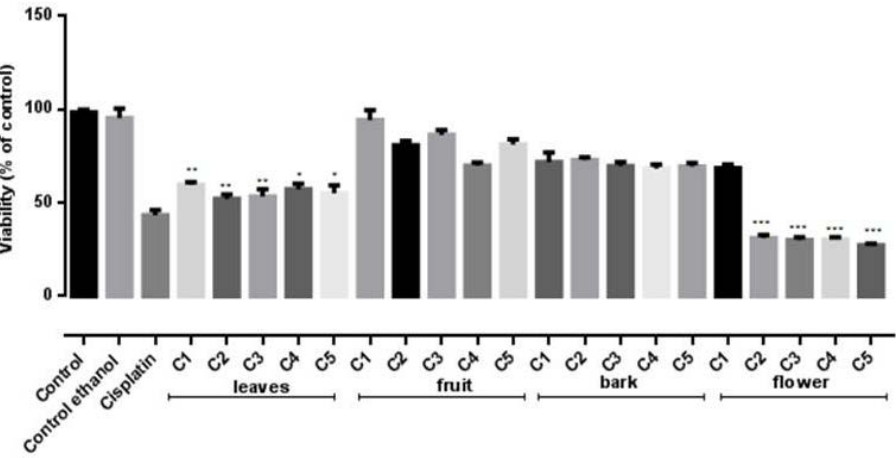
Figure 4. Inhibitory effects on B16H10 cell line of S. vulgaris leaves, fruit, bark and flowers extracts at five different concentrations C1–C5 calculated according to the TPC ( µ mol GAE/mL) determined for each extracts: leaves (11.34–56.7 µ mol GAE/mL), fruit (6.66–33.2 µ mol GAE/mL), bark (9.875–49.37 µ mol GAE/mL) and flowers (11.69–58.475 µ mol GAE/mL); Negative control—untreated cells, Internal control—Ethanol, Positive control—Cisplatin. Values represent the mean ± SD of three determinations. * p < 0.05; ** p < 0.001; *** p < 0.0001 (Differences between extract—treated cells and the negative control).